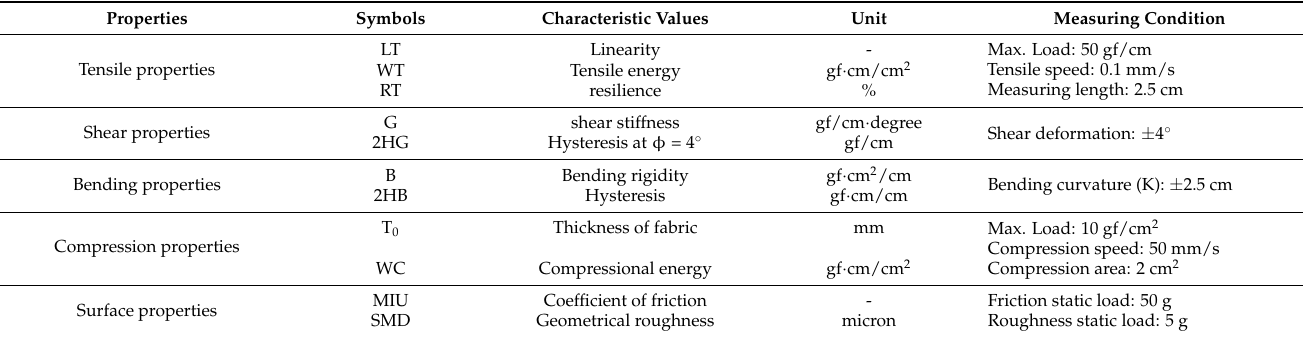
Table 1. Measurement parameter of the KES-FB